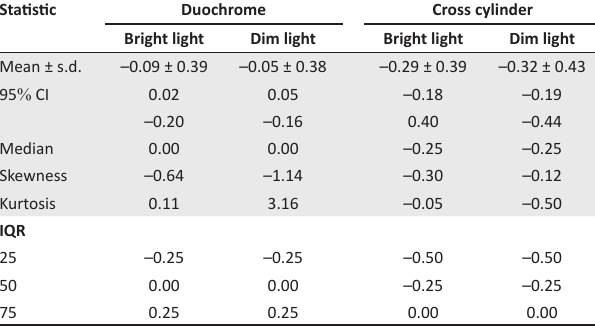
difference. Horizontal lines are drawn at the mean difference, whilst the 95 % limits of agreement (LoA) are presented by the upper and lower lines. The upper and lower LoA are equal to the mean difference ± 1.96 × s.d. The mean differences between the duochrome and cross cylinder measurements were generally positive but low values (< 0.26 D). The largest mean difference was seen between the duochrome and TABLE 1: Descriptive statistics for the duochrome and unfused cross cylinder tests in dioptres. Statistic